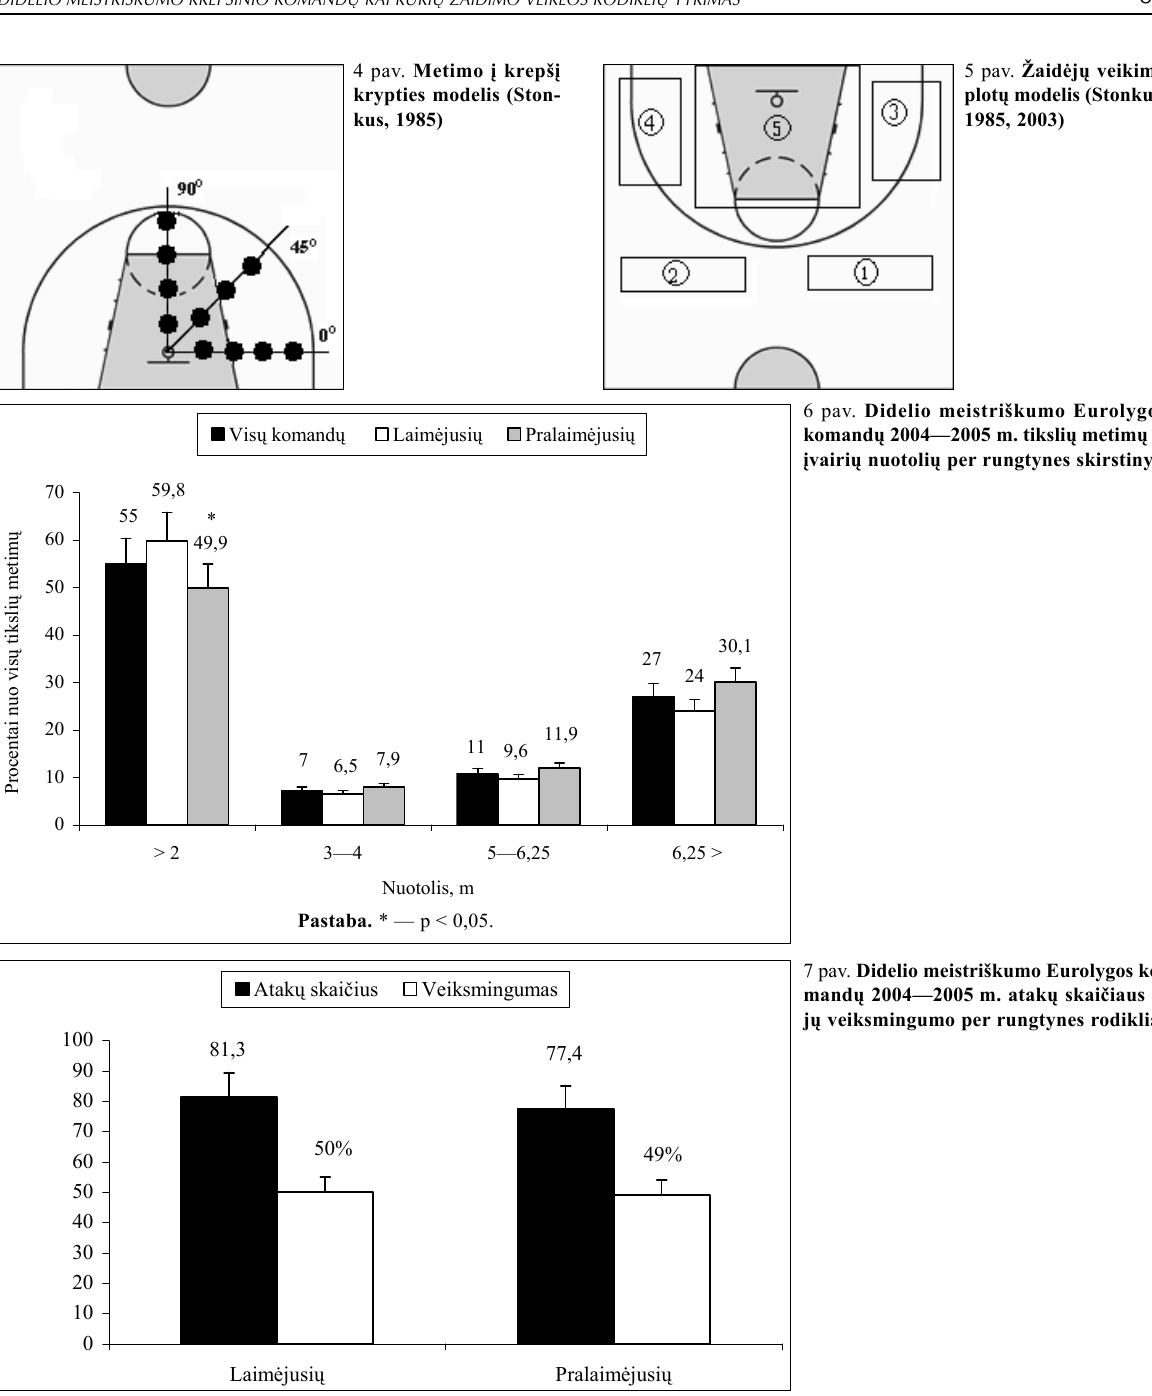
21—24 s trukm ė s atak ų komandos per rungty- nes vidutiniškai surengdavo po 12,3 (15,5% vis